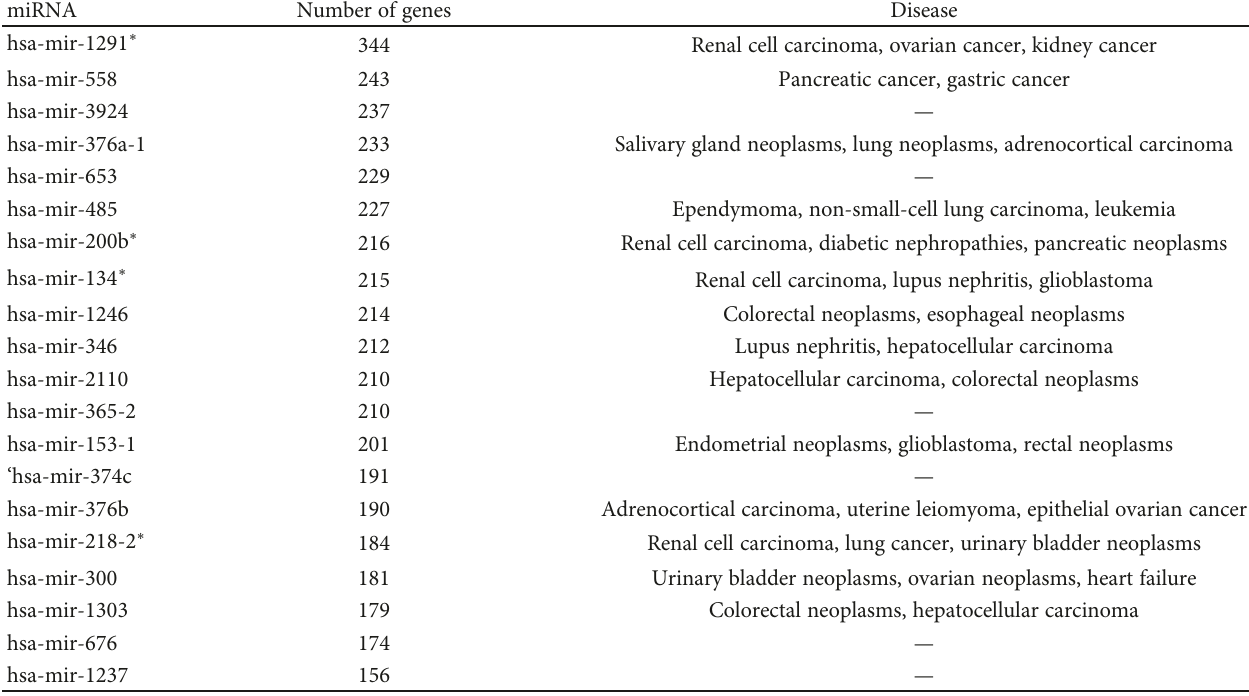
Table 3: The annotation of the top 20 miRNAs in